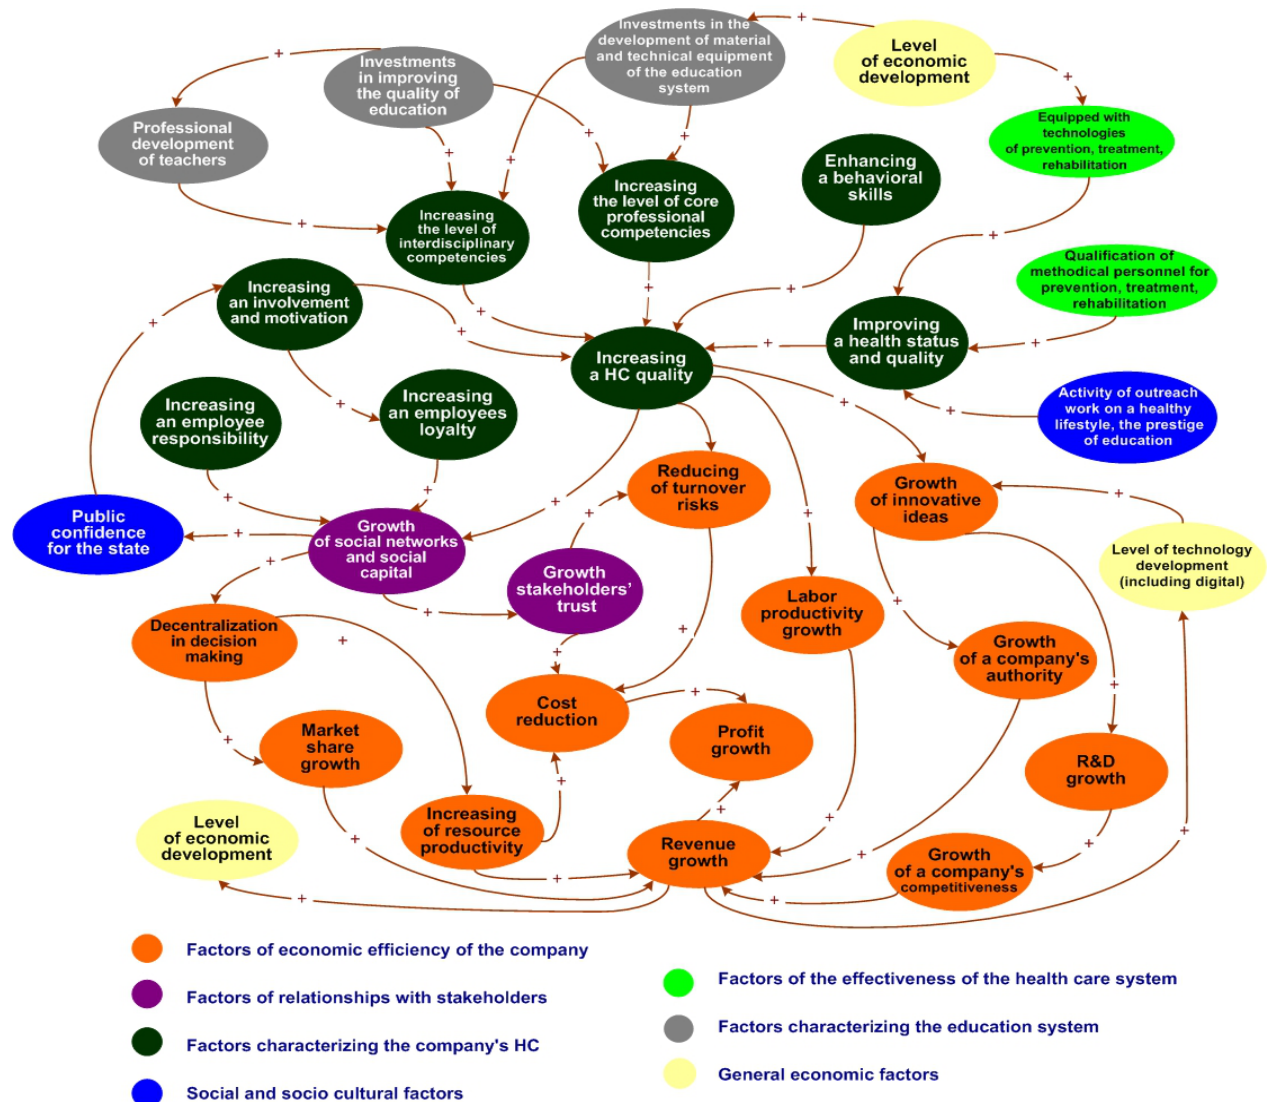
Figure 6. Poorly formalized cognitive diagram for HC factors depending on a companies’ efficiency.